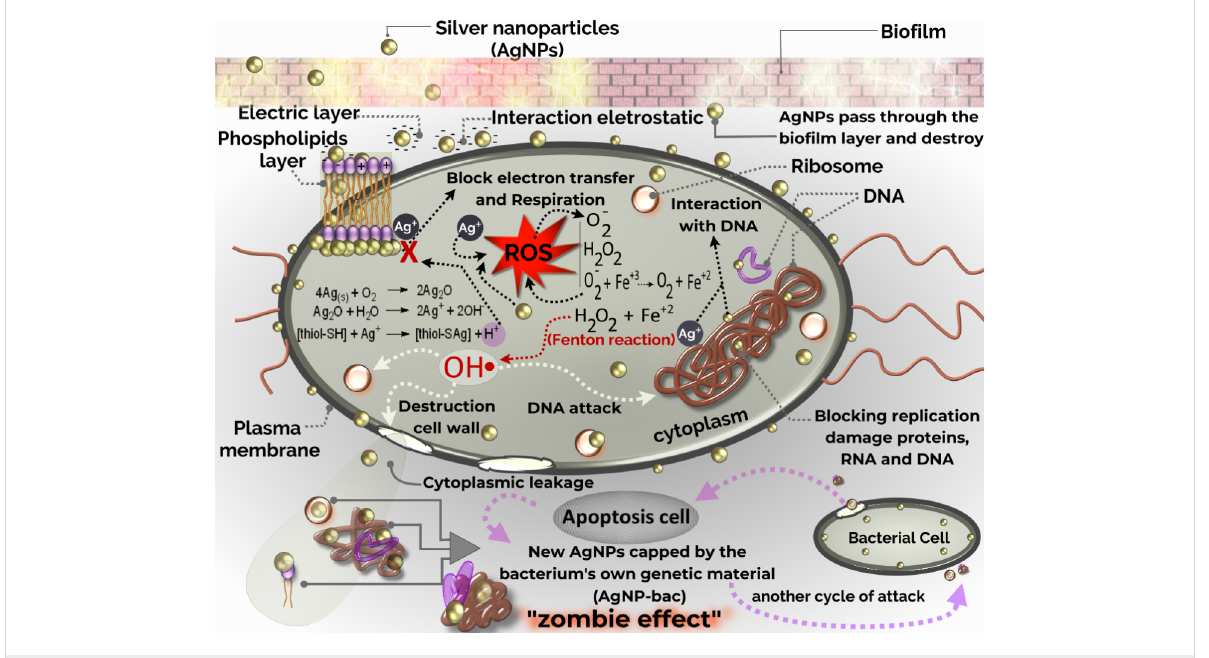
Figure 6: Mechanism of action of AgNPs in the bacterial cell.